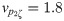
Parkinsonian activity in the STN.(a) Power spectrum of STN firing rate ϕζ for vp2ζ=1.8 mVs. (b) Power spectrum of STN firing rate ϕζ for vp2ζ=2.4 mVs.